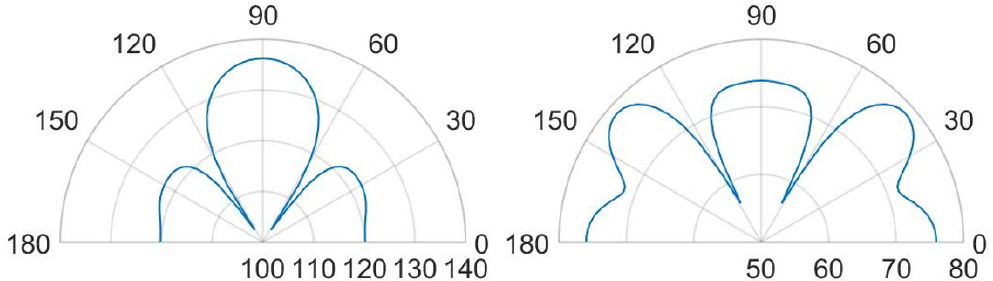
Figure 16. SPL polar plot (dB) at the performing fundamental frequency of 93.0 kHz (3 V bias), at 3.5 cm in the y(90 ◦ )-z(0 ◦ ) plane: unpackaged device ( left ), packaged device ( right